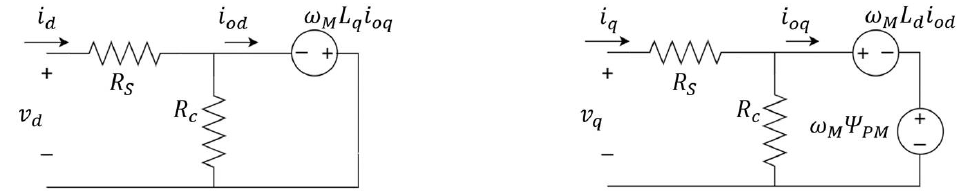
Figure 9. Synchronous machine equivalent circuit considering core-losses on a d-q reference frame.